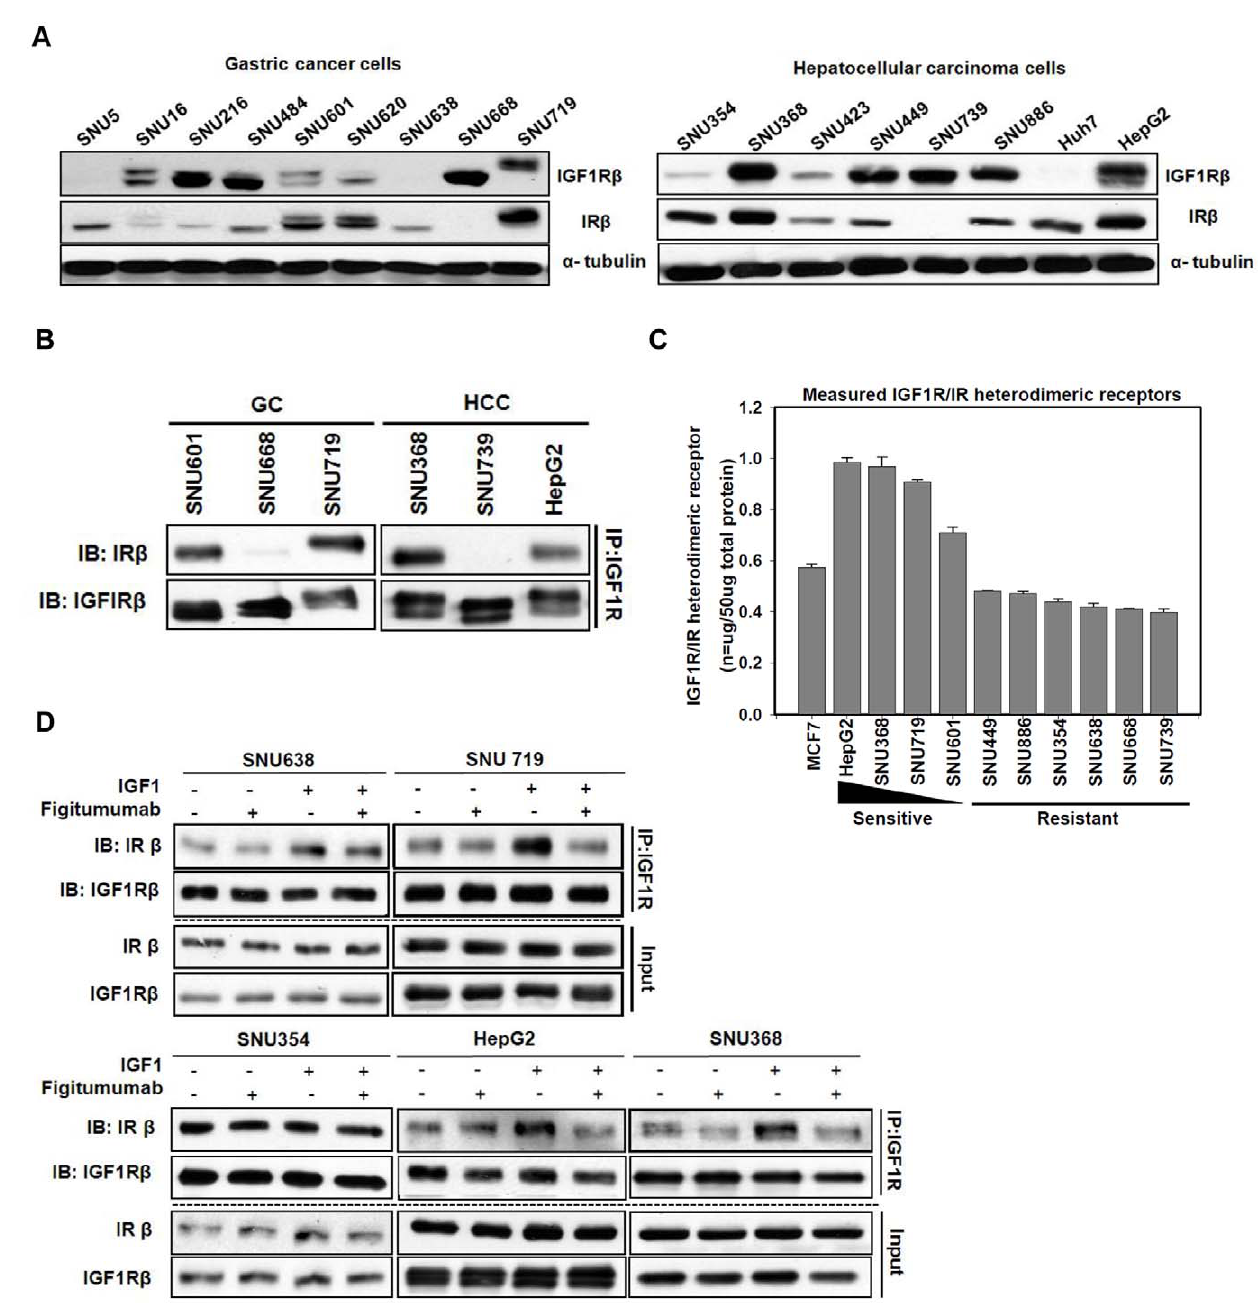
Figure 2. Analysis of IGF1R, IR, and IGF1R/IR HR levels in cancer cells sensitive to anti-IGF1R antibody. A) Immunoblot analysis of total IGF1R b and IR b protein levels. Two types of gastric and hepatocellular carcinoma cells were harvested 24 h after plating and immunoblotting with anti-IGF1R b antibody, anti-IR b antibody, and anti- a tubulin antibody was performed. For both types of cells, representative blots from three independent experiments are shown. B) Analysis of the presence of IGF1R/IR heterodimeric receptor (HRs) using immunoprecipitation. Total cellular proteins (1 mg) from cells were used for immunoprecipitation with anti-IGF1R antibody, separated by SDS-PAGE at constant voltage (80 V), and Western blotted with an anti-IR b antibody. The blot was then stripped and reprobed with anti-IGF1R b antibody C) Quantitative analysis of IGF1R homodimer, IR homodimer, and IGF1R/IR heterodimer levels using an ELISA. Lysis buffer (100 m L) containing equal amount of proteins (50 m g/well) from 11 cancer cell lines including MCF7 cells (positive control) were plated on anti-IGF1R antibody-coated wells and detected with an anti-IR detection antibody. Anti-IR antibody-coated wells, IR protein standards, and the anti-IR detection antibody were used as standards in the heterodimeric receptor ELISA. Absorbance was measured at 450 nm. Values are expressed as the mean 6 SEM nanograms of receptor protein per 50 m g total protein. Cell lines are listed according to their sensitivity to figitumumab. Bars= 6 SE. D) Effect of figitumumab on IGF1- mediated IGF1R/IR HRs. Cells were serum-starved for 24 h and then treated with figitumumab, IGF1, or left untreated. SNU719 cells were incubated with figitumumab (10 m g/mL) for 1 h at 37 u C followed by stimulation with IGF1 (100 ng/mL) for 30 min. Immunoprecipitation was performed with an anti-IGF1R antibody and Western blotted. Input=total cell lysate without IP.